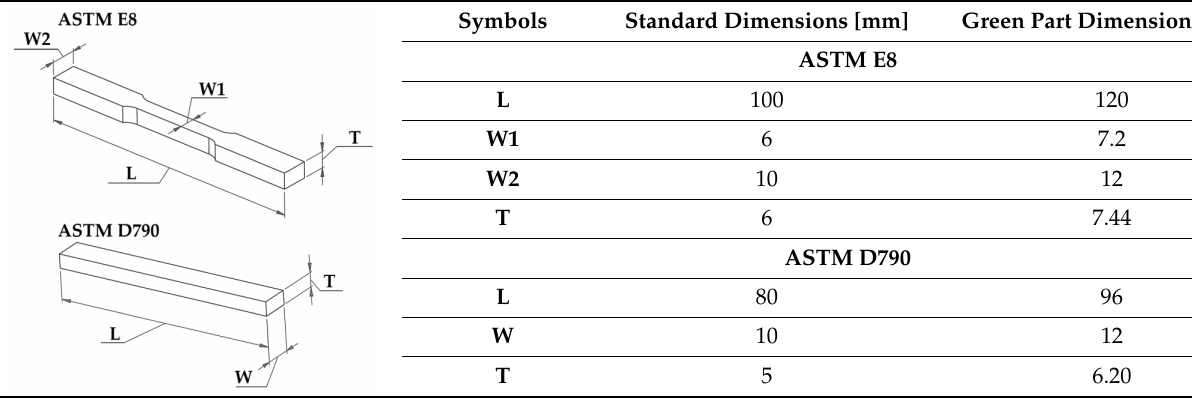
Table 4. Standard (ASTM E8 and D790) and green part dimensions for Ultrafuse 316L